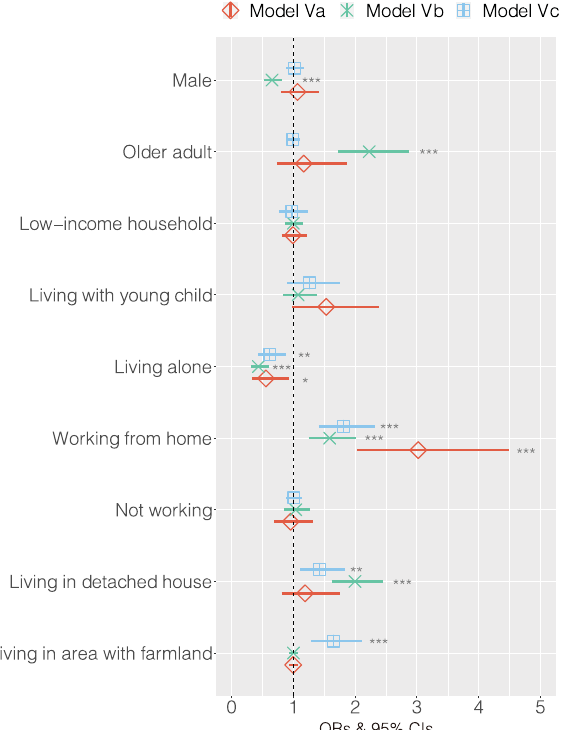
Fig. 5 The associations between local food access and socio- demographic characteristics. Allotment farm users ( a ), home gardeners ( b ), and farm stand users ( c ). The diamond ( ◊ ), cross (x), and square ( □ ) symbols indicate the ORs of allotment farms, home gardens, and farm stands, respectively. The vertical dashed line is the reference line and is set to one. The error bars represent the 95% CIs. Predictors are interpreted to be signi fi cant if their 95% CIs do not cross one line. The signi fi cant results are shown as follows: * p < 0.05, ** p < 0.01, and *** p <